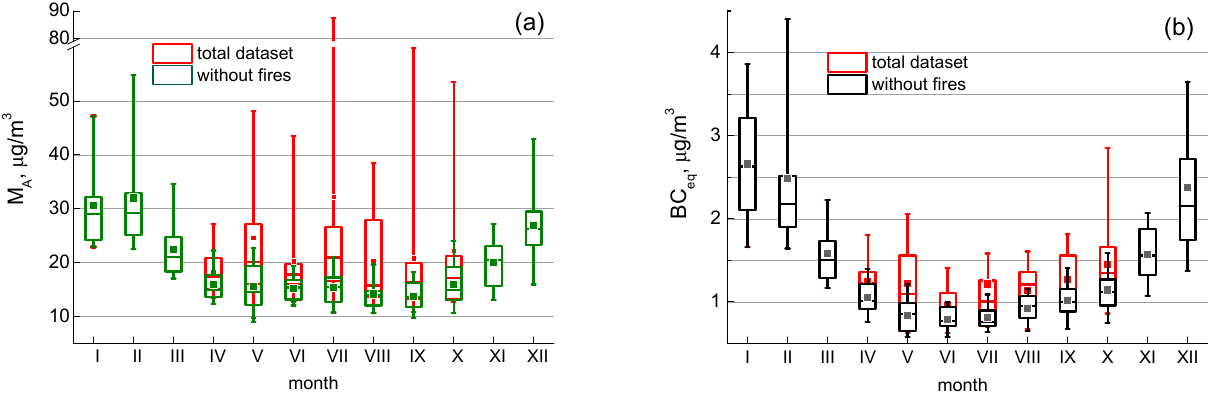
Figure 2. Multiyear seasonal behavior of mass concentrations of ( a ) submicron aerosol and ( b ) black carbon (BC) eq at the Aerosol Station (suburban region of Tomsk) in 1997–2018. Red boxes indicate the total dataset. Green and black boxes are for datasets without accounting for the contribution of situations with wildfires. The lower and upper sides of the box show the 25 and 75 percentile concentrations, respectively; the horizontal bars represent the median; and the closed squares give the mean. The whiskers represent the 5th and 95th percentile concentrations.